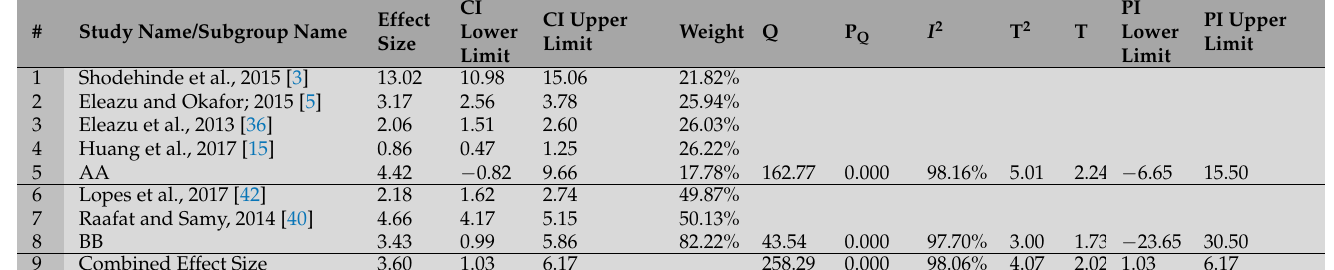
Figure 1. Moderator analysis showing strong correlation between moderator and effect size for the included studies in meta-analysis. Arithmetical irregularity remained calculated employing I 2 value (Tables 4 and 5). Table 4. Subgroup meta-analysis showing effect size, I 2 and PI values for AA and BB.